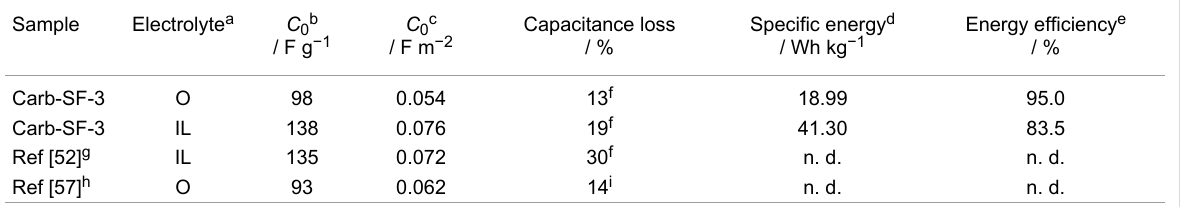
Table 2: Electrochemical data summary for sample Carb-SF-3 measured in two different electrolytes.